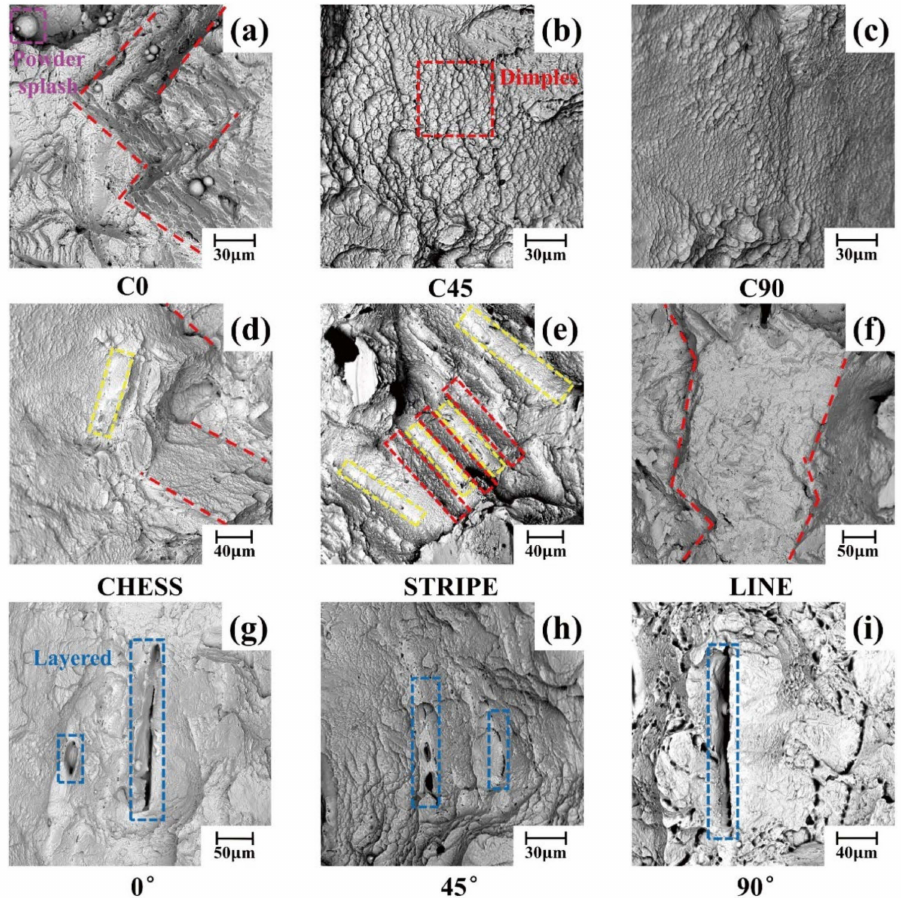
Figure 10. Tensile fracture morphologies of L-PBF samples under different combinations of scanning strategies and a single scanning strategy. ( a – c ) Tensile fracture morphologies of C0, C45, and C90 samples; ( d – f ) CHESS, STRIPE, LINE single scanning strategy sample tensile fracture morphology; ( g – i ) tensile fracture morphologies of samples with single scanning strategy at 0 ◦ , 45 ◦ , and 90 ◦